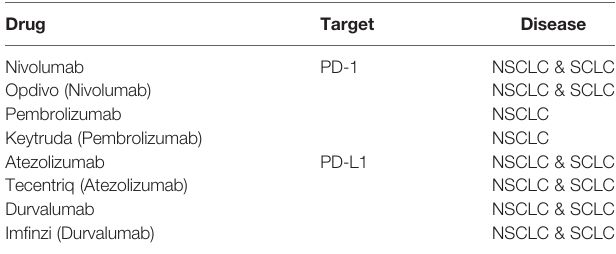
TABLE 1 | PD-1 inhibitor Nivolumab (or Opdivo) have been approved for treatment of NSCLC and SCLC, another PD-1 inhibitor Pembrolizumab (or Keytruda) have been approved for SCLC